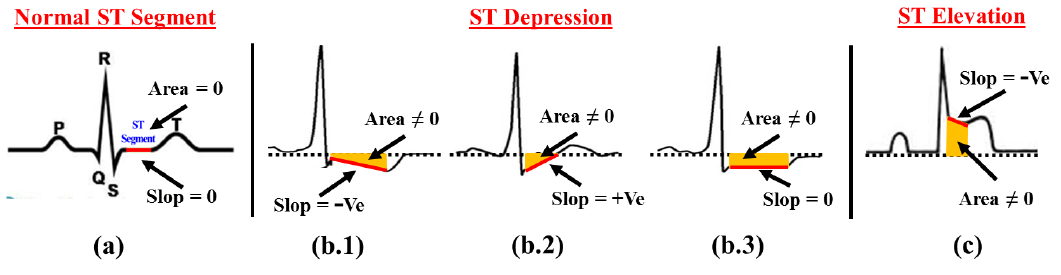
Figure 7. ST Segment abnormality detection method ( a ) Normal ST Segment; ( b.1 – b.3 ) ST Depression; ( c ) ST